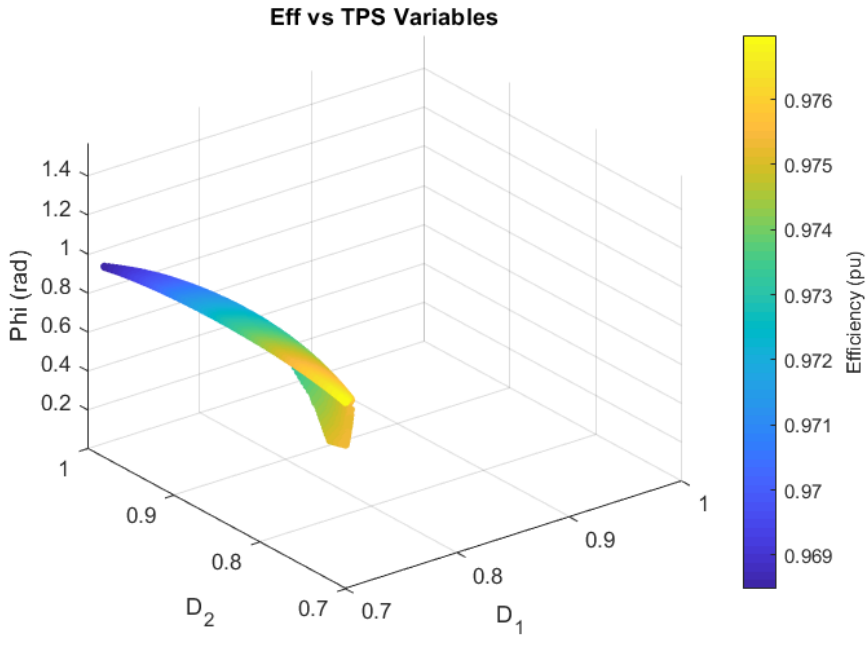
Figure 6. Optimal control variables vs.